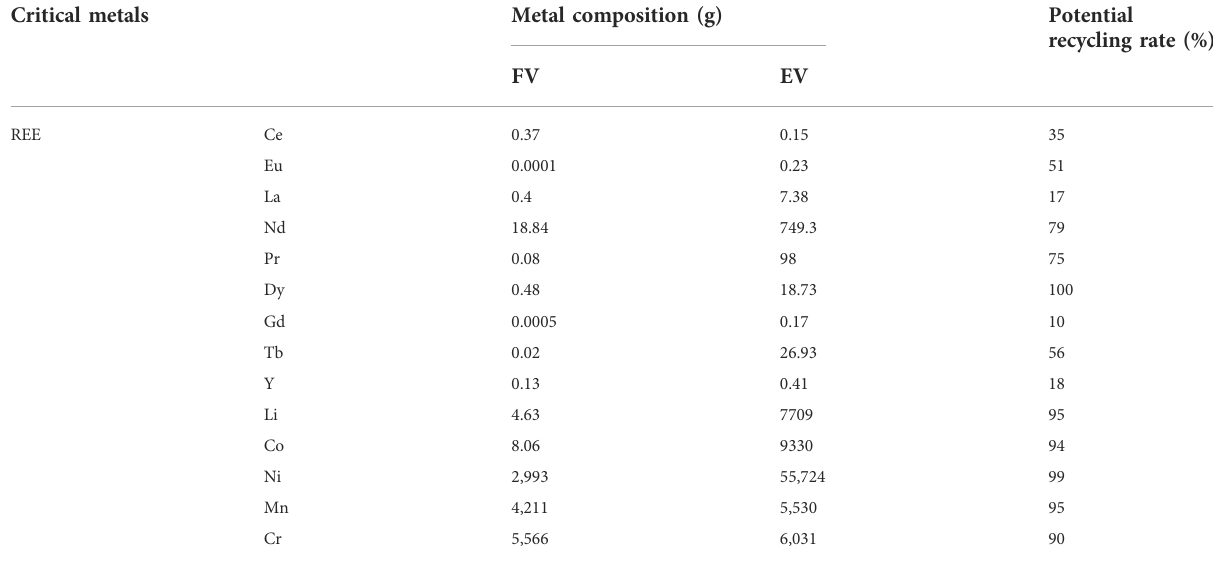
TABLE 3 Metal composition of each type of vehicle and potential recycling rate. Critical